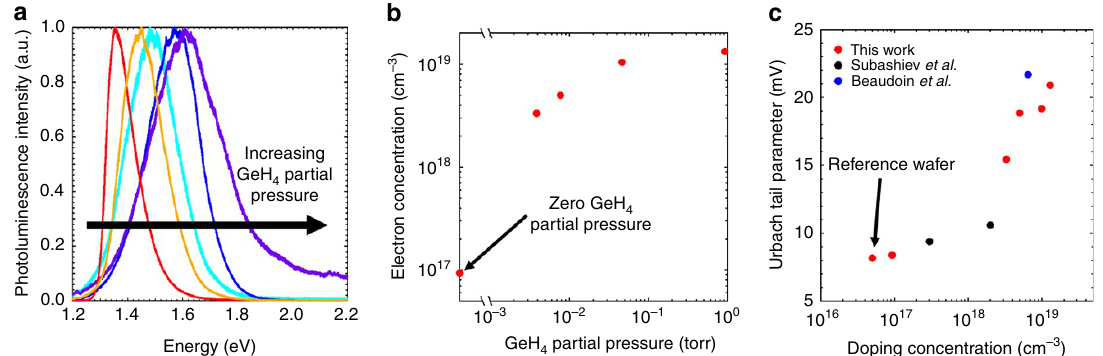
Figure 3 | In situ doping. ( a ) Photoluminescence spectra of five InP samples grown with GeH 4 pressures of 0, 3.9, 7.7, 46 and 900mTorr of GeH 4 . As the GeH 4 partial pressure is increased, the peak of the photoluminescence spectra blue-shifts, signifying higher electron concentrations. ( b ) A plot of the electron concentration, approximated from the peak position of the photoluminescence spectra using the Burstein–Moss effect, as a function of the GeH 4 partial pressure. ( c ) The Urbach tail parameter is plotted versus the approximated doping level showing that the crystal quality is on par with that of single- crystalline wafers/films at different levels of doping. NATURE COMMUNICATIONS|7:10502|DOI: